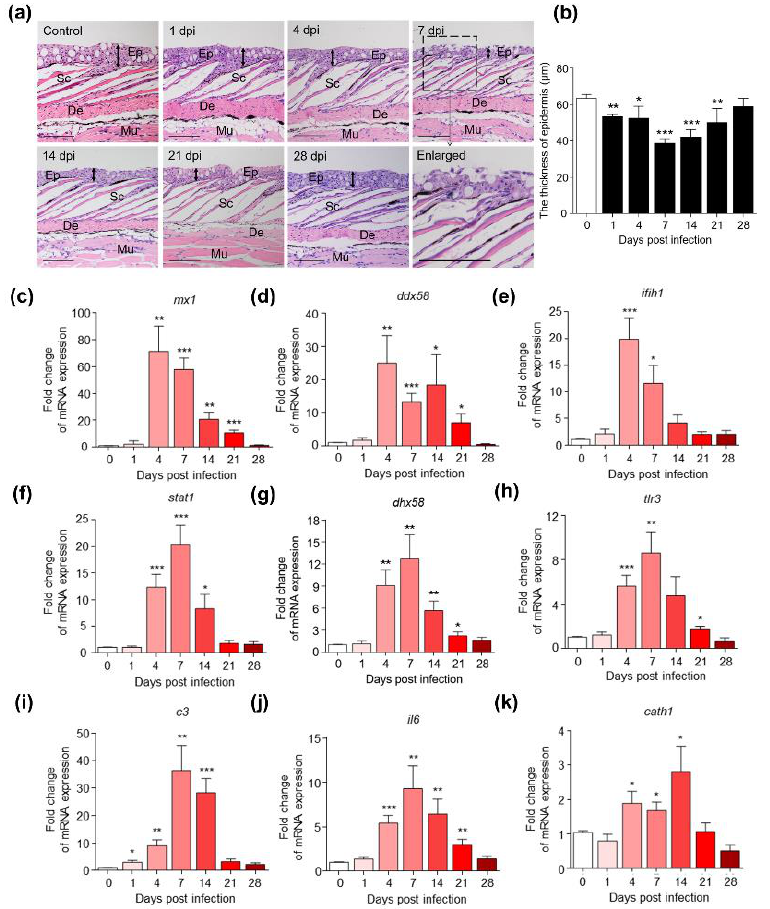
Figure 2. Histopathological changes and gene expression changes in rainbow trout skin after IHNV invasion. ( a ) Hematoxylin–eosin (H&E) staining of skin paraffin sections at the indicated time points. Ep, epidermis; Sc, scale; De, dermis. Scale bars, 100 µ m. Black two-way arrows represent the location of the epidermal thickness measurement. ( b ) Histogram showing the thickness of skin epidermis at the indicated time points (n = 6). ( c – k ) Histogram comparing the expression of 9 immune-related genes (mx1, ddx58, ifih1, stat1, dhx58, tlr3, c3, il6, cath1) at indicated different time points following IHNV infection. In all cases, the expression at 0 dpi was taken as a calibrator against which the relative levels of other time points were calculated. * p < 0.05, ** p < 0.01, *** p < 0.001.